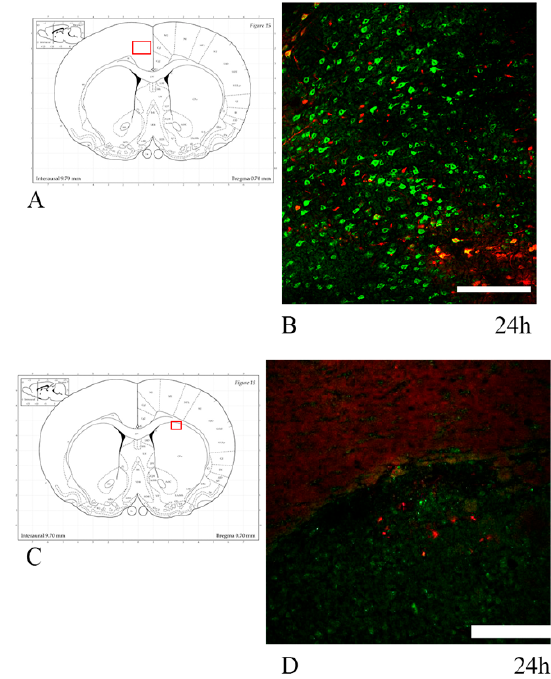
Figure 12. HSP70 / ATF3 / APP expression reflecting neuronal stress. ( A , F ) The highlighted area refers to the area represented in each row. ( B – E ) HSP70 (red) and APP (green) double staining in the dorsal cortex. While APP expression remains elevated through 7 d, HSP70 expression is comparatively decreased at 7 d. Few neurons are HSP70 +/ APP + . ( G – J ) ATF3 (red) and APP (green) double staining in the habenular nuclei. ATF3 follows the same expression pattern as HSP70, with decreased marker uptake at 7 d. In all cases, sham animals do not express any of the tested markers, with only the baseline marker uptake visible. Scale bar = 150 µ m (Scale bar = 100 µ m in image ( F )).